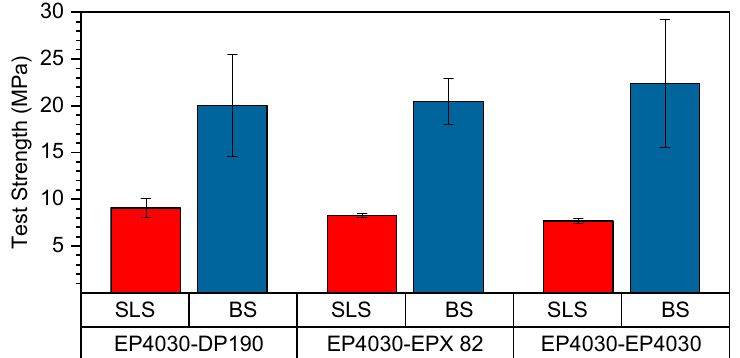
Figure 13. Comparison between single-lap shear (SLS) and block shear (BS) test results for the three different bonding materials.